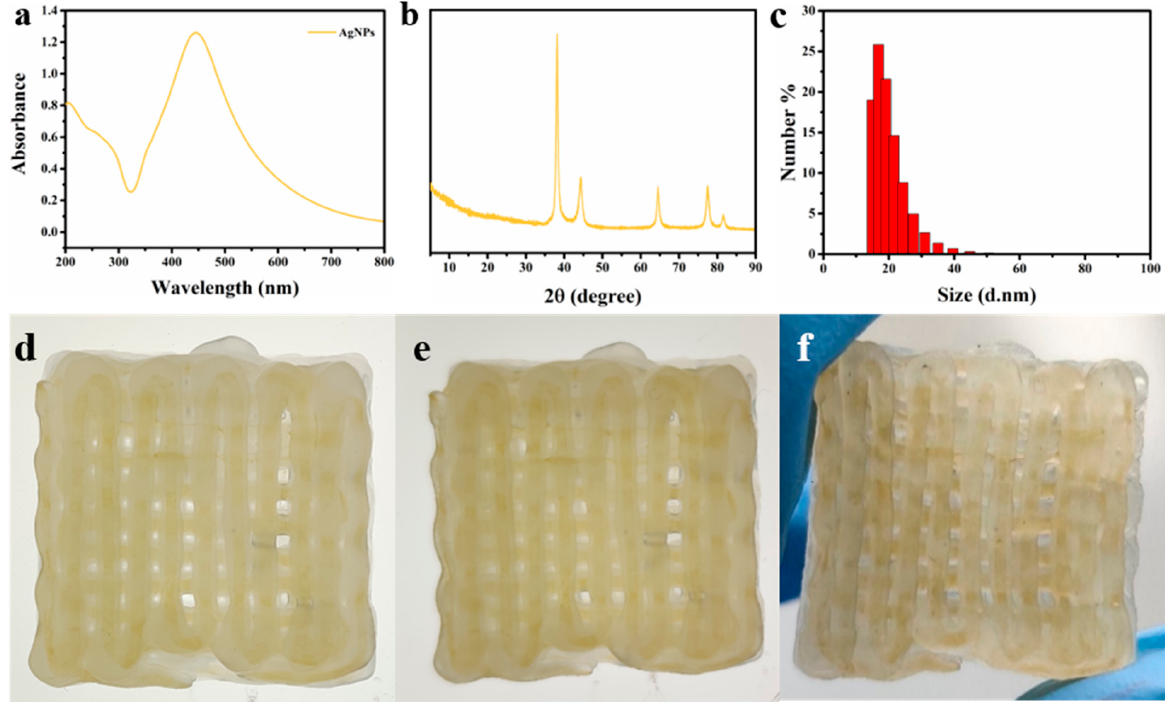
Figure 5. ( a ) Ultraviolet spectrum, ( b ) XRD spectra and ( c ) particle size of silver nanoparticles (AgNPs); photographs of CMC-based 3D-printed aerogel ( d ) before curing, ( e ) after curing, and ( f ) after freeze drying.